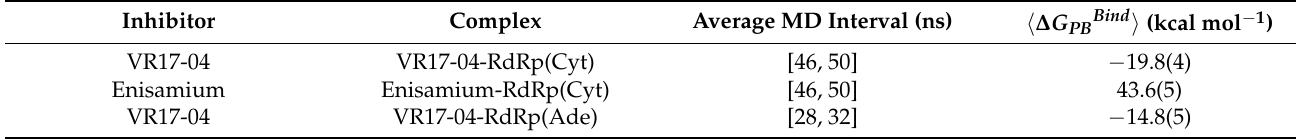
Table 4. Poisson Boltzmann free energy of binding (cid:104) ∆ G PBBind (cid:105) estimated as average value using the MMPBSA methods; the corresponding error on the mean is reported in brackets. The time interval for the average estimation is